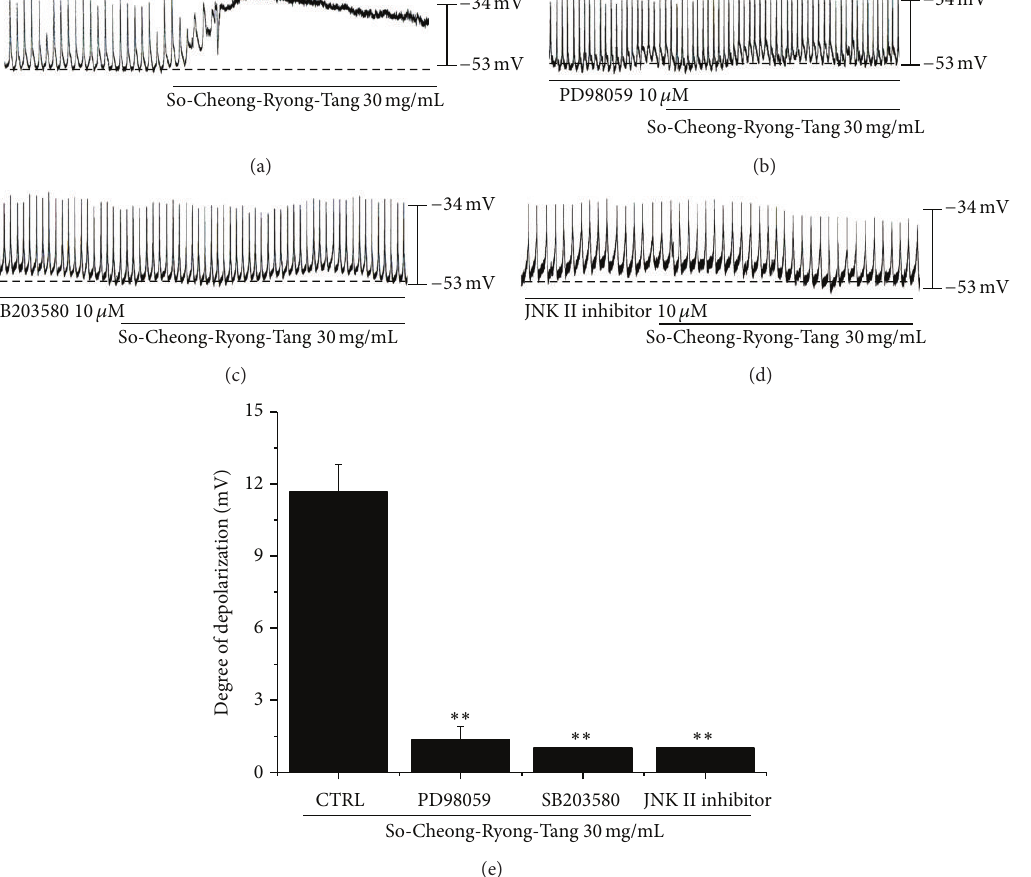
Figure 6: Effects of various MAPK inhibitors on SCRT-induced pacemaker potentials responses in cultured ICCs. (a) SCRT (30mg/mL) induced membrane depolarizations on ICCs. (b) Pacemaker potentials of cultured ICCs exposed to SCRT (30 mg/mL) in the presence of 10 𝜇 M of PD98059 (a p42/44 MAPK inhibitor). (c) Pacemaker potentials of cultured ICCs exposed to SCRT in the presence of 10 𝜇 M of SB203580 (a p38 MAPK inhibitor). (d) Pacemaker potentials of an ICC exposed to SCRT in the presence of 10 𝜇 M of JNK II inhibitor. Responses to SCRT in the presence of different MAPK inhibitors are summarized in (e). Bars represent mean values ± SEs. ∗∗ 𝑃 < 0.01 . Significantly different from untreated controls. CTRL: